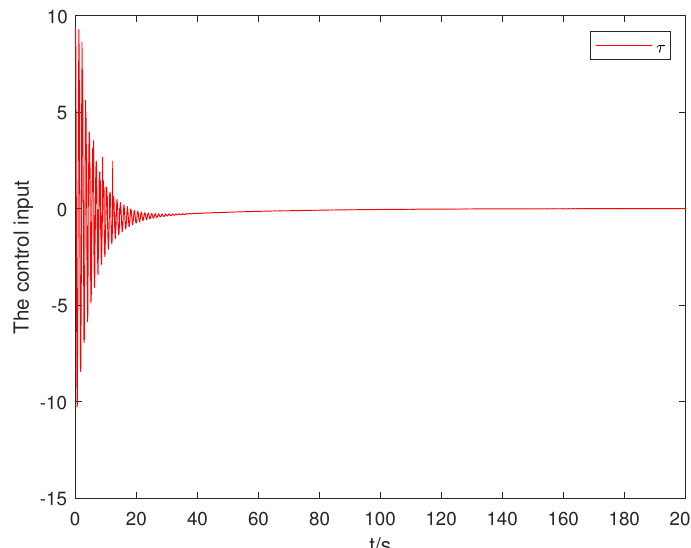
Figure 5. Curves of the force